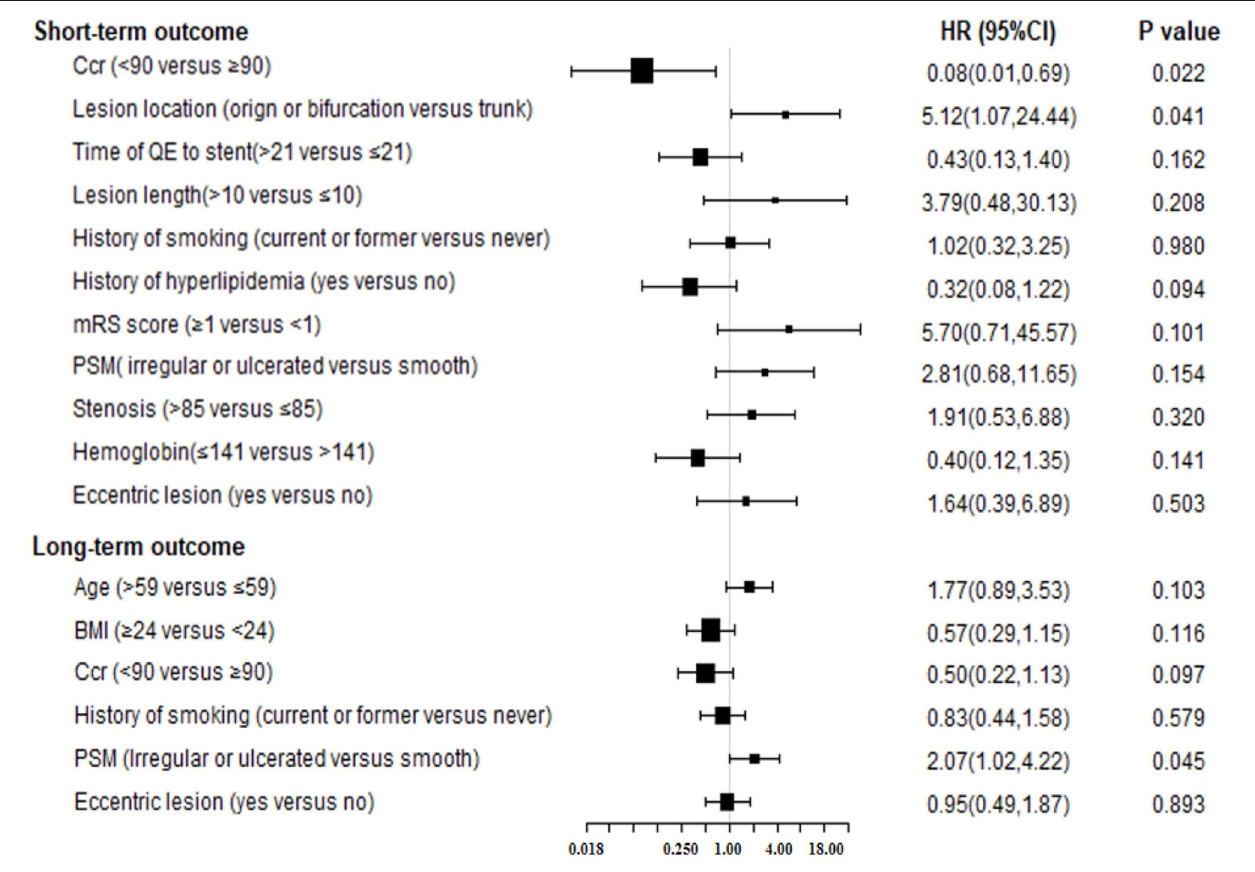
FIGURE 1 | The forest plot for results of Cox multivariable analysis for short or long-term outcome by “change-in-estimate” method. Ccr, creatinine clearance; QE, qualifying event; PSM, plaque surface morphology; BMI, body mass index; HR, hazard ratio; CI, confidence